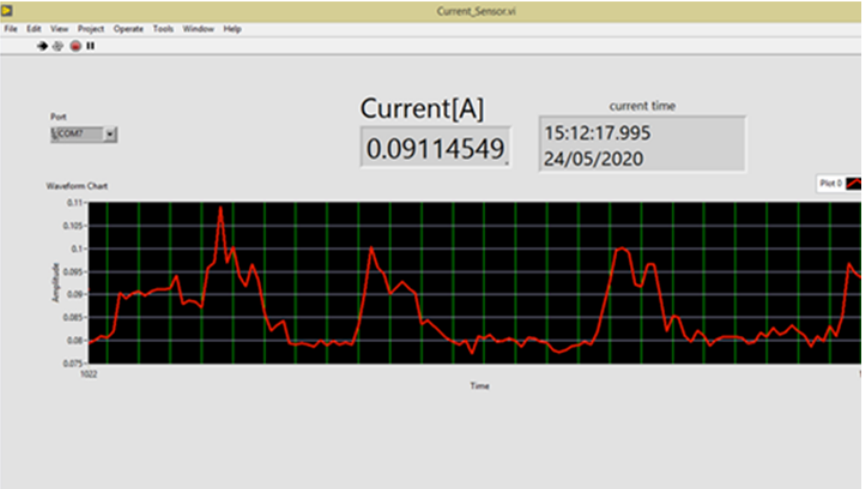
Figure 4. Current acquisition process LabVIEW graph.